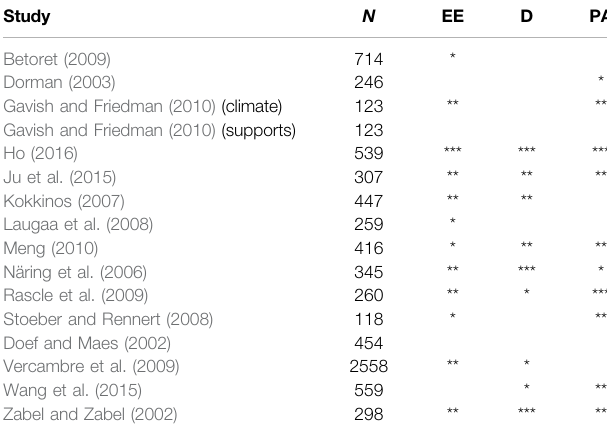
TABLE 3 | Relationships with pupils and burnout.